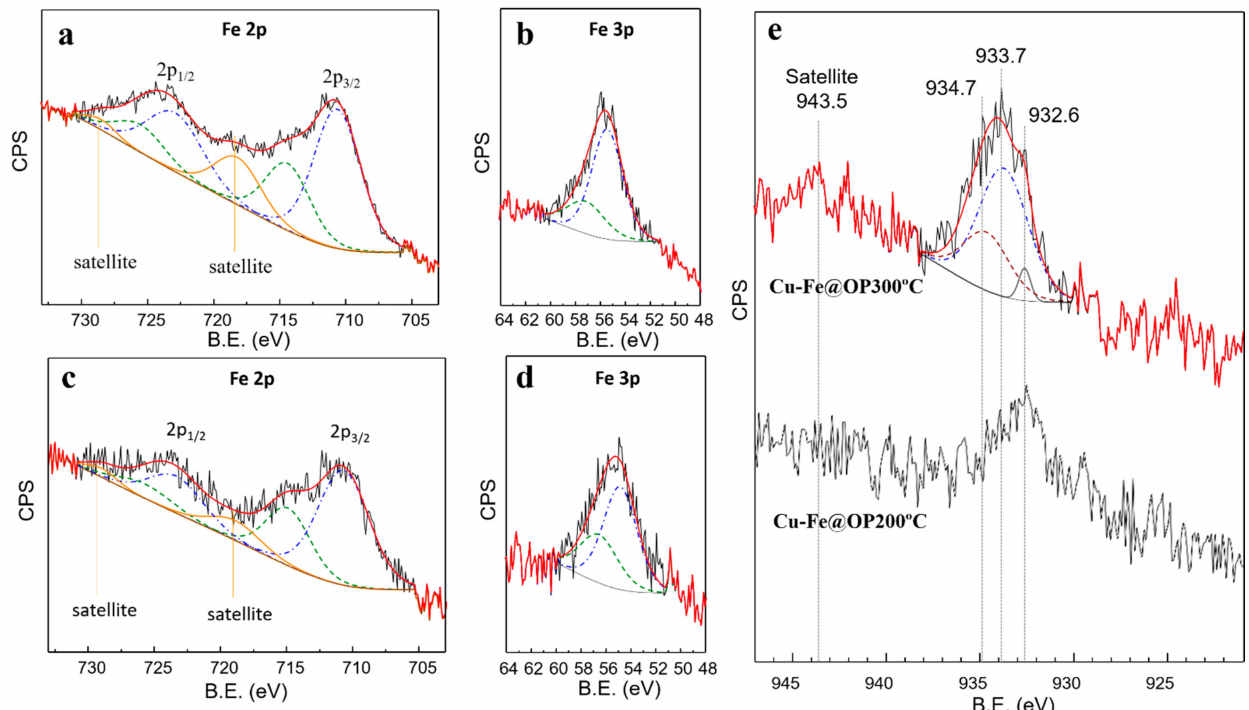
Figure 4. Curve fitting analysis of ( a ) XPS Fe2p and ( b ) Fe3p core levels of Cu-Fe@OP300 ◦ C catalyst; curve fitting analysis of ( c ) XPS Fe2p and ( d ) Fe3p core levels of Cu-Fe@OP200 ◦ C catalyst; ( e ) XPS Cu2p3/2 core level measurements for Cu-Fe@OP200 ◦ C and Cu-Fe@OP300 ◦ C